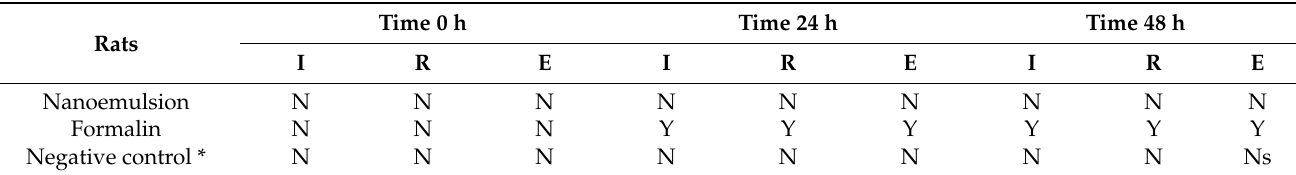
Table 16. Skin irritation study of the optimized nanoemulsion